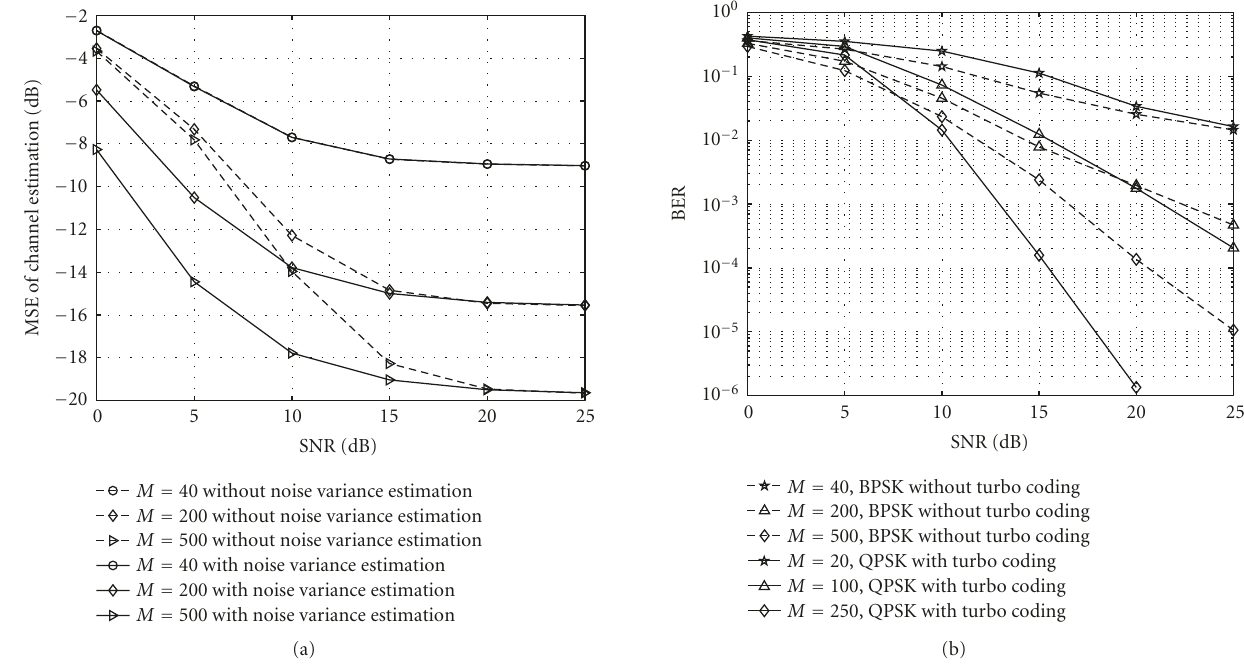
Figure 6: Example 2, synchronous two-branch transmission with two receivers, N = 3( L + 1), data rate = 1.5, (a) normalized channel estimation MSE versus SNR, (b) BER versus SNR (with noise variance